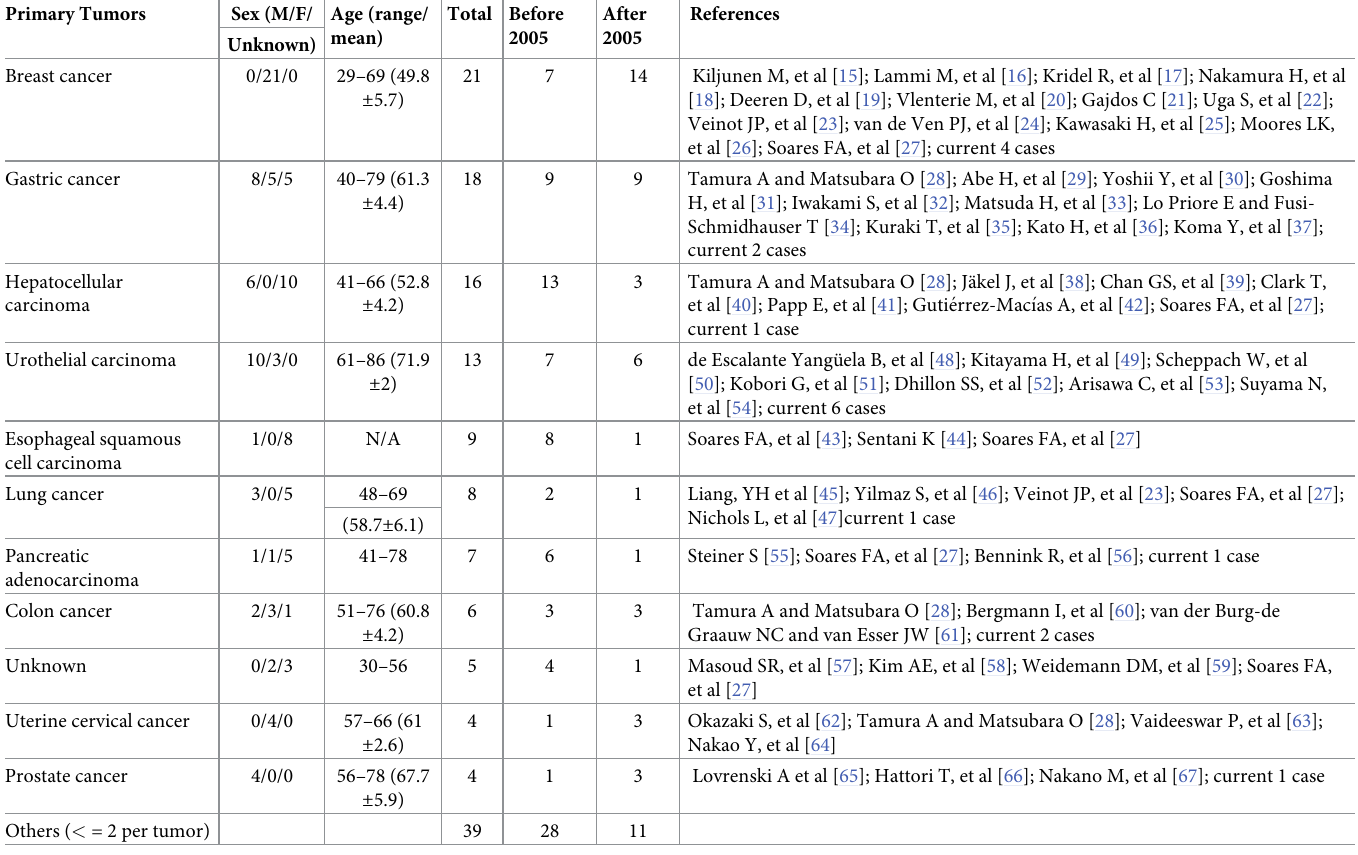
Table 5. Combination of pulmonary tumor embolism cases of our institution with the literature. Primary